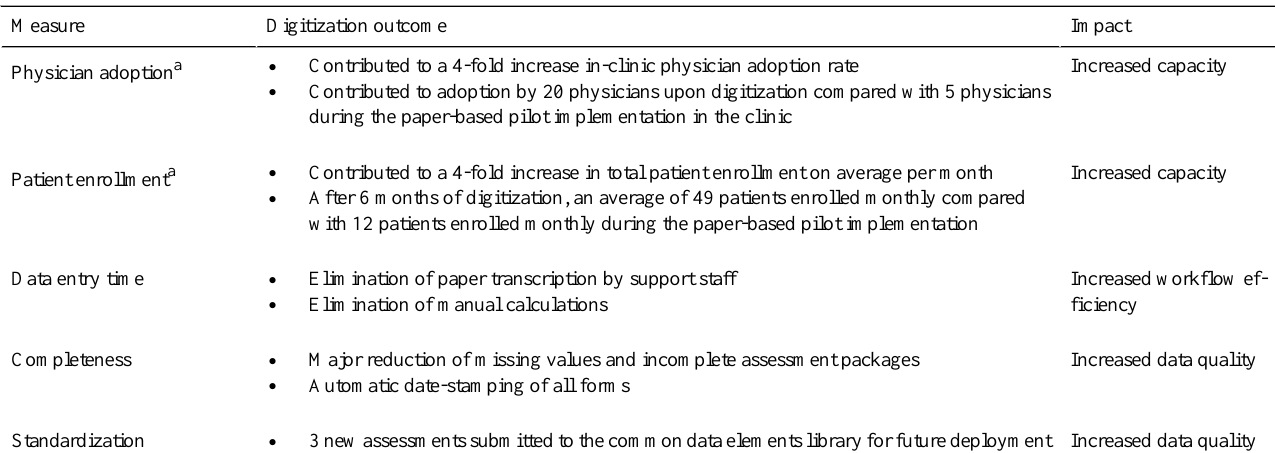
Table 1. Overview of the impact and outcomes of Centre for Addiction and Mental Health major depressive disorder integrated care pathway digital transformation.